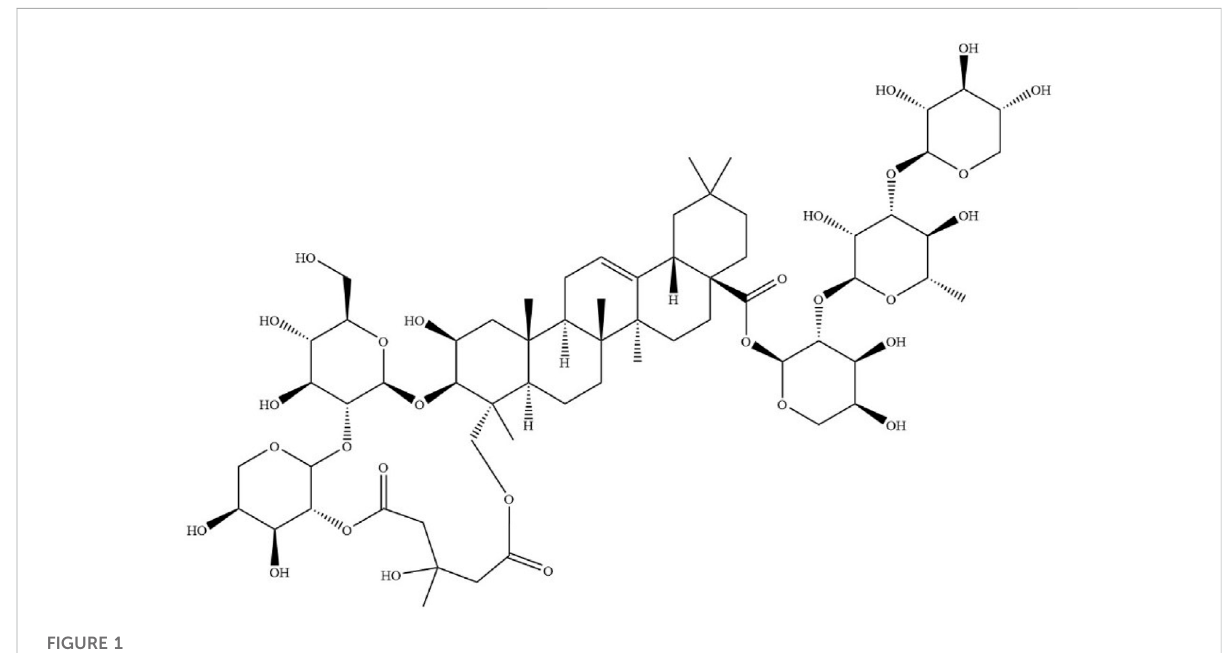
FIGURE 1 Chemical structure of TBMS-1.